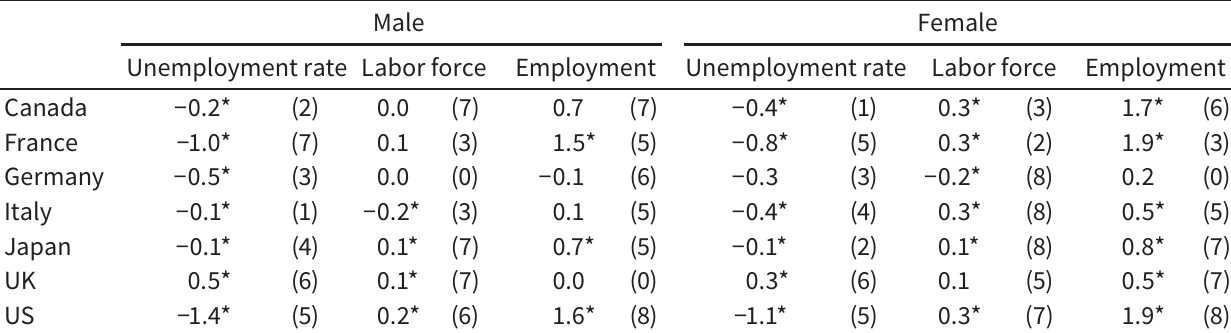
Table 2 Impacts of spending shocks on female and male unemployment, labor force, and employment during